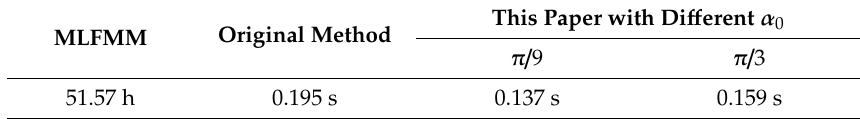
Figure 3. Geometrical structure of the ship model ( a ) and the RCS results vary with the incident angle ( b ). Table 1. Comparison of calculation e ffi ciency between the MFLMM, the original GO / PO method, and the proposed